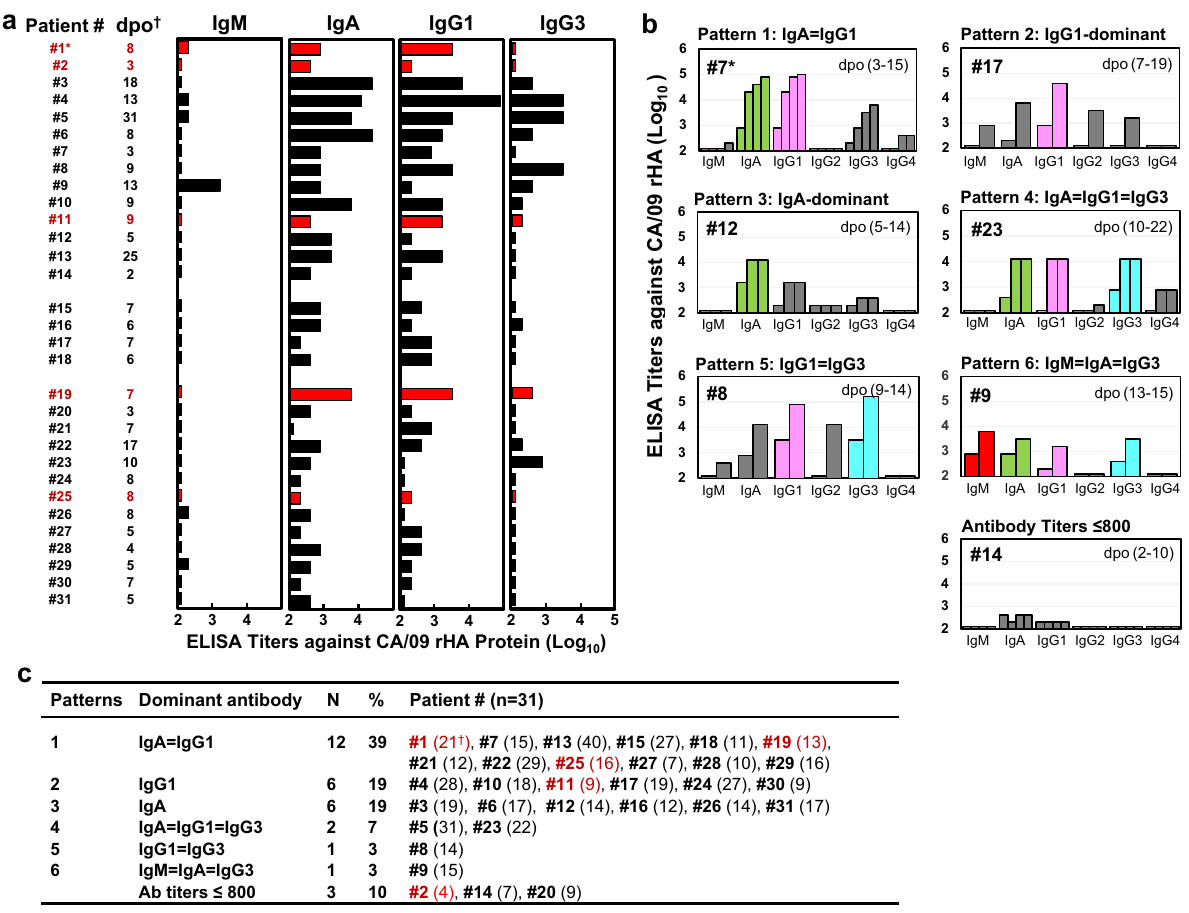
Figure 5. CA/09 HA-specific antibody isotype and IgG subclass responses. Sera were tested by ELISA using rHA from wt-CA/09. ( a ) IgM, IgA, IgG1, and IgG3 antibody responses in 31 patients. ELISA antibody titers are illustrated by black bars for survivors and red bars for fatal patients. ( b ) Representative patients showed 6 different antibody isotype and IgG subclass immunodominance response patterns. Antibody titers are shown in gray bars, but dominant and co-dominant isotype and IgG subclass are highlighted in other colors: IgG1 in pink, IgG3 in cyan, IgA in green, and IgM in red. ( c ) Summary of antibody isotype and IgG subclass response patterns at indicated serum collection time in 31 patients (Supplementary Table 4). *Fatal patients in red, † serum collection days post-symptom onset (dpo). For each serum sample, we completed two independent ELISA A(H1N1) viruses compared to wt-CA/09 virus. Deceased patient #2 also had eightfold higher IgG antibody titers for BR/60 rHA-head compared to CA/09 rHA-head. In contrast, patients #6 and #29 had lower IgG antibody titers for BR/60 rHA-head compared to CA/09 rHA-head and equal IgG antibody titers for wt-CA/09 and1977- 2007 A(H1N1) viruses (Fig. 4c). Taken together, our data indicated that infection with CA/09-like viruses induced cross-subtype, even cross- type HAI antibody responses targeting (K130 + Q223)-epitope(s) in some ICU patients. However, only cross-type antibodies displayed lower IgG antibody titers for wt-CA/09 compared to pre-pandemic A(H1N1) viruses and/or rHA-head of IBV. Such low-avidity cross-type antibodies likely contributed to fatal outcomes in some patients. Most ICU patients did not exhibit IgG1‑dominant serum antibody responses. Antibody iso- types and IgG subclasses were tested with sera from 31 patients by ELISA using CA/09 rHA (Fig. 5 and Sup- plementary Table 4). We found that 13 patients showed very low IgG1 titers (S1 ≤ 200); 9 patients had ≥ fourfold higher IgA than IgG1; patient #9 possessed mainly IgM and IgA in their S1 (Fig. 5a). Nevertheless, significantly increased (≥ fourfold) IgM (n = 8, 26%), IgA (n = 20, 65%), IgG1 (n = 23, 74%), IgG2 (n = 8, 26%), IgG3 (n = 18, 58%), and IgG4 (n = 5, 16%) antibody responses were observed while patients were in the ICU (Supplemen- tary Table 4). Next, we analyzed immunodominance of antibody isotypes and IgG subclasses. We considered antibody isotype/IgG subclass antibody titers showing ≥ fourfold higher than others as dominant-antibodies. Examples of 6 immunodominance patterns were presented in Fig. 5b. Three patients (#2, #14, and #20) displayed low ELISA titers (≤ 800), and patients (n = 28) were grouped into 6 different patterns based on the sera collected at the indicated time (Fig. 5c and Supplementary Table 4). Only 6 (19%) patients exhibited IgG1-dominant responses. Most patients (68%) were IgA-dominant (n = 6), or IgA co-dominant with other isotype/IgG sub-